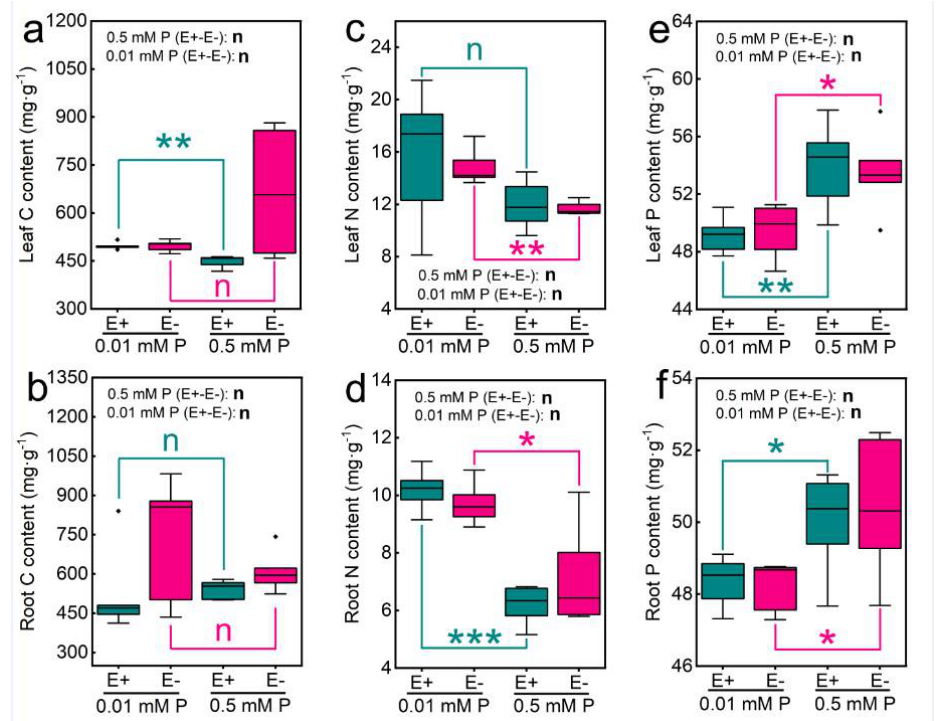
Figure 2. The content of C, N, and P of leaves (a,c,e) and roots (b,d,f) in E− and E+ plants at 0.01 and. 0.5 mM P. *, ** and *** showed differences at p < 0.05, p < 0.01, and p < 0.001, respectively.